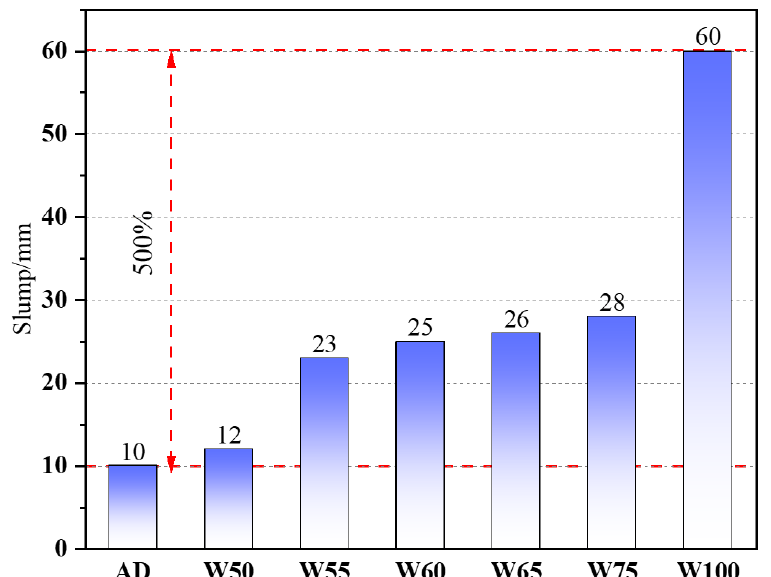
Figure 8. The slump of recycled